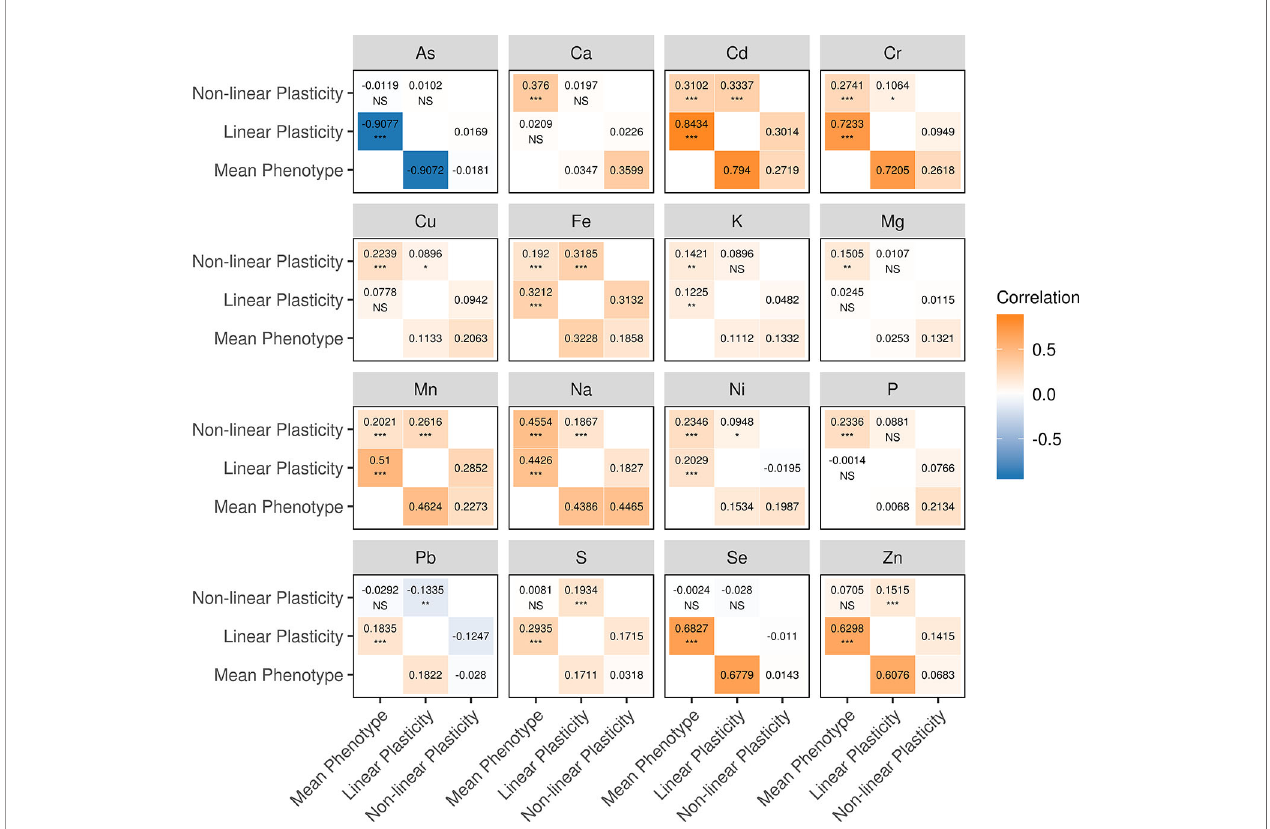
FIGURE 2 | Correlations among the mean phenotype, linear plasticity, and non-linear plasticity for each element. (upper-triangle) The numbers are the values of the Pearson correlation coef fi cients ( r ). The signi fi cance levels (adjusted with the Bonferroni correction) of the correlations are shown below the correlation coef fi cients: “ *** ” indicates a P value < 0.001, “ ** ” indicates a P value < 0.01, “ * ” indicates a P value < 0.05, “ NS ” indicates a P value ≥ 0.05. (lower-triangle) The genetic correlation coef fi cients (